Question: Briefly state, in one sentence, what is plotted here.
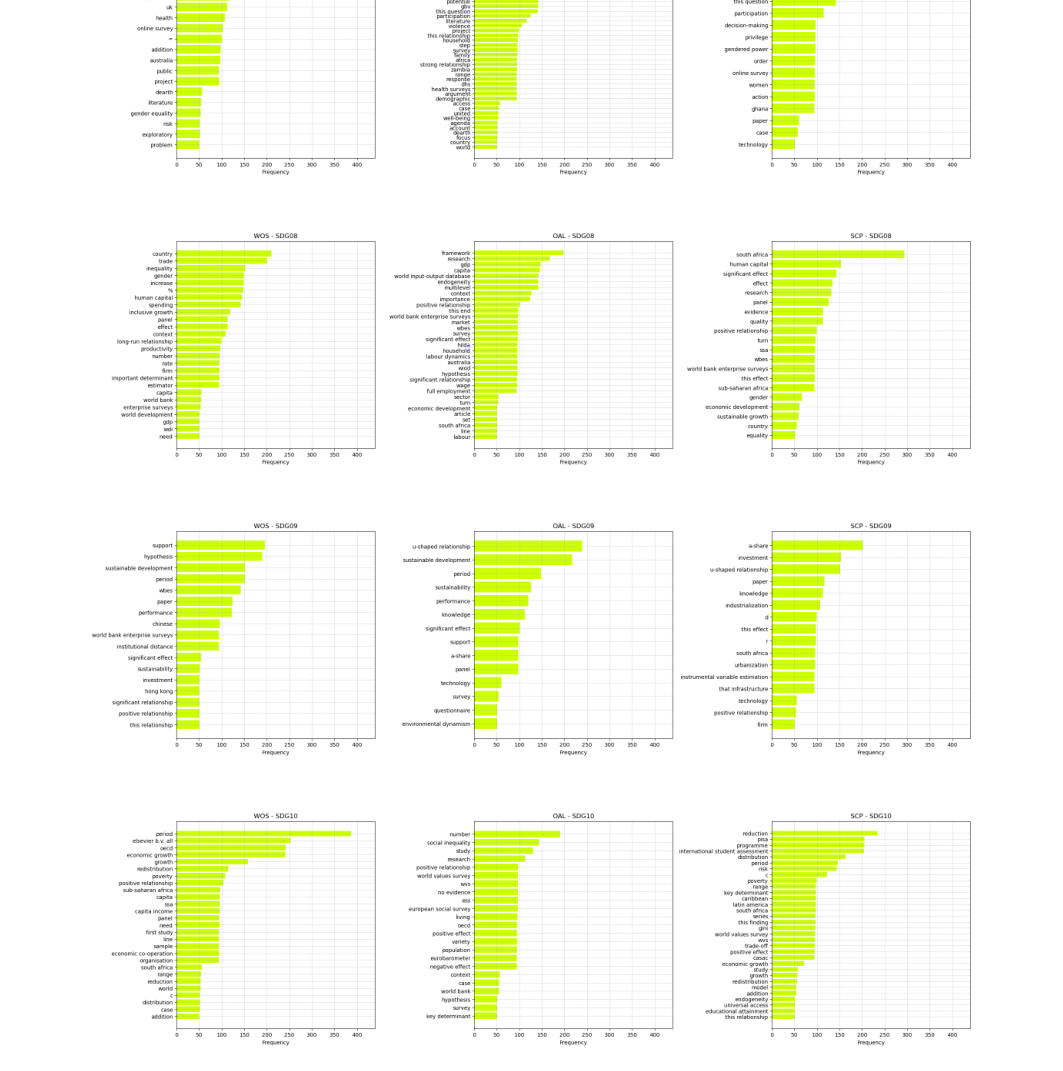
Answer: For each SDG and bibliometric DB, frequency bar charts of the ”unique” sets; i.e., noun phrases sets except those items that are in common among the three databases.